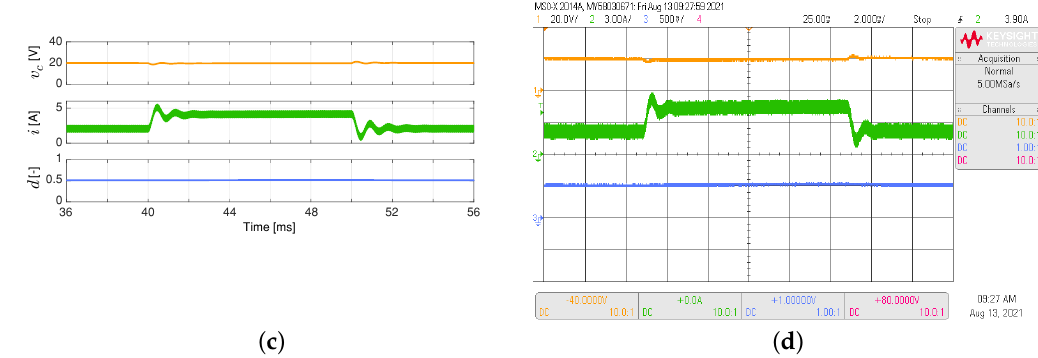
Figure 5. Simulated ( a , c ) and experimental ( b , d ) dynamic responses of the boost converter when the load resistance is a 50 Hz square waveform between 10 Ω and 20 Ω , and a duty cycle of 0.5: ( a , b ) adaptive PI-PBC controller, ( c , d ) PI controller. CH1: v c (20 V/div), CH2: i (3 A/div), CH3: d (500 mV/div), CH4: 1/ G L (20 V/div) (it is calculated only by the PI-PBC controller), and time base of 2ms.